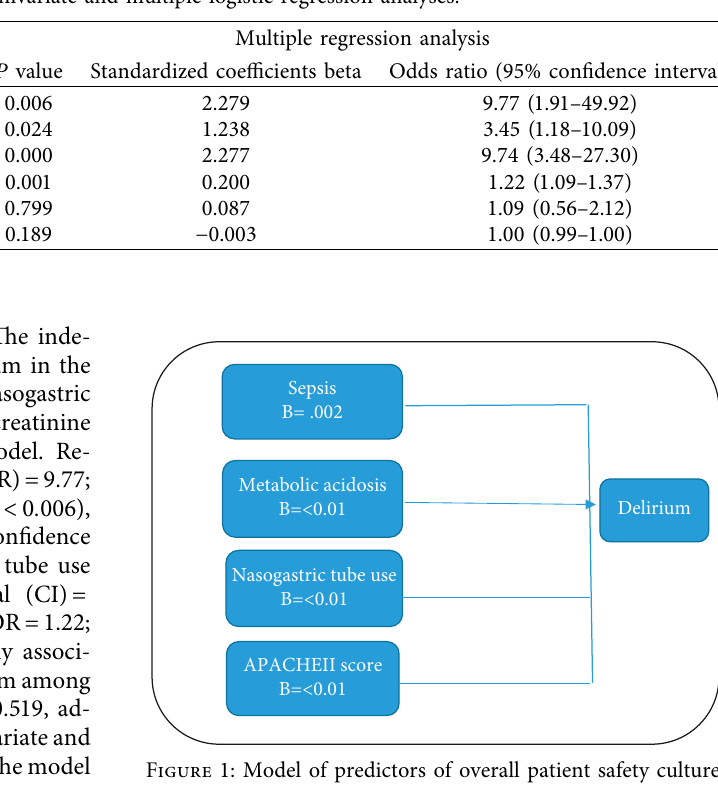
Table 2: Results of the univariate and multiple logistic regression analyses.